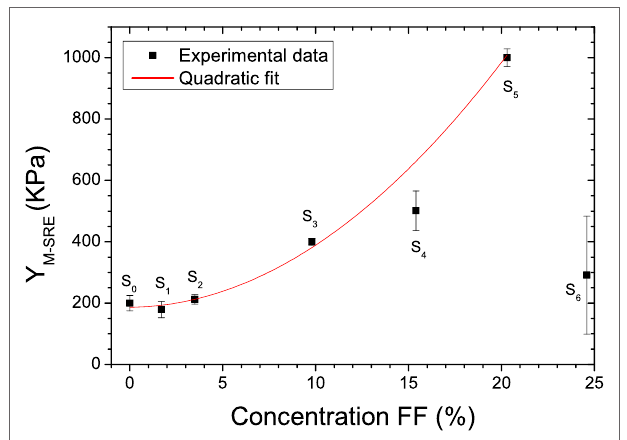
fields.FigUre 6 | Transmittance as a function of wavelength for slab samples with a thickness of 250 μ m of PDMs (s 0 ) and the M-sres (s 1 –s 6 ) .